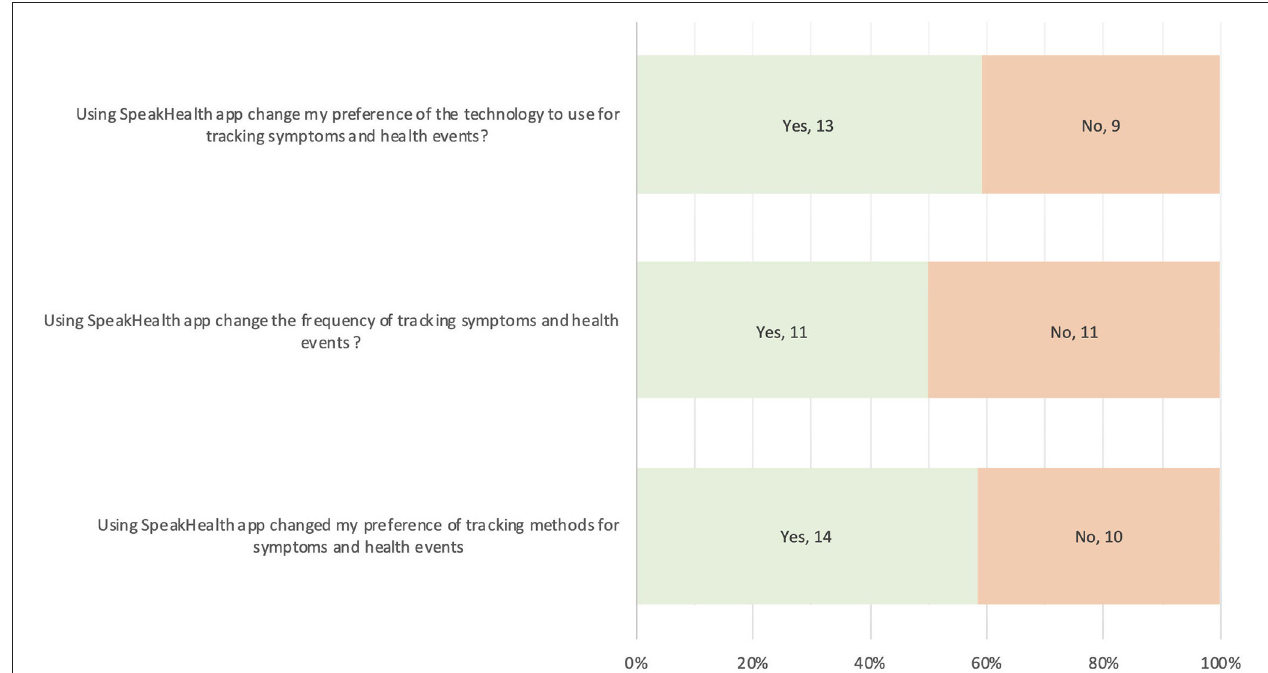
FIGURE 3 | Responses to technology use preferences in care